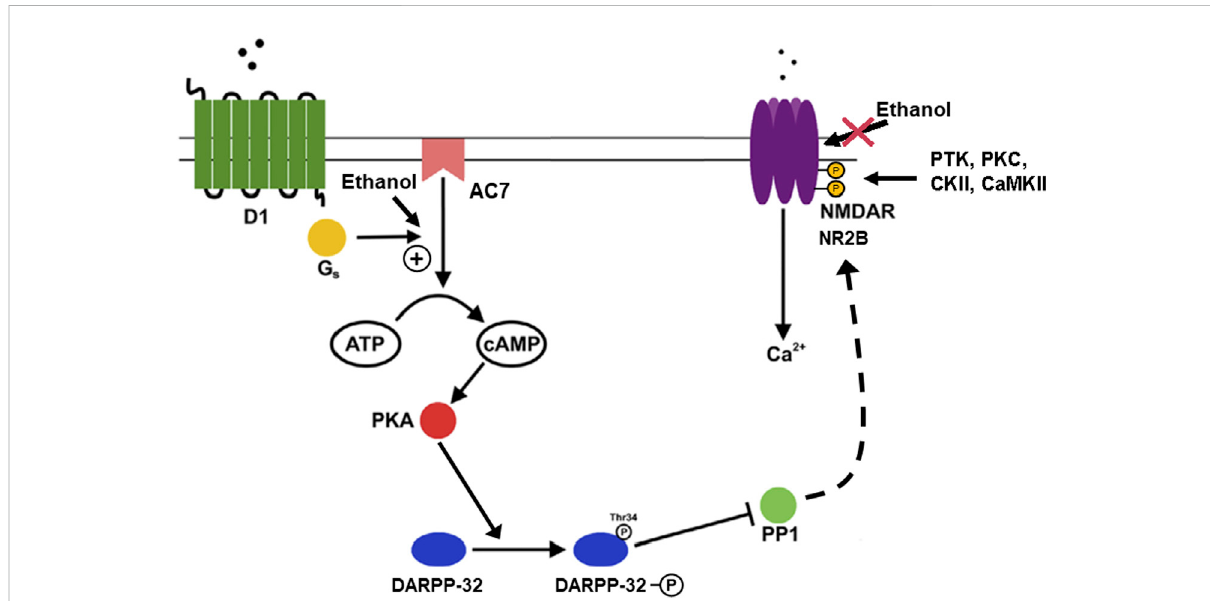
FIGURE 4 Phosphorylation of DARPP-32 mediated by dopamine through AC7 and actions of ethanol. The activity of medium spiny neurons (GABAergic neurons) in the nucleus accumbens and other areas of the striatum are important in the control of reward-related dopamine signals mediated via D1andD2dopaminereceptors,withD1receptorsactingtoenhancedendriticexcitability(Surmeieretal.,2007).Theincreaseindendriticexcitability isproposed tobedependentonmodulationofcortico-striatalglutamatergicsignaling via NMDA receptorslocatedonthedendriteswhichalso contain the D1 receptors. The link between the dopamine and glutamate signals is provided by the actions of PKA, DARPP-32, and protein phosphatase 1 (PP1) (Fernandez et al., 2006). The fi gure illustrates that ethanol, by acting on AC7, increases the production of cAMP which activates PKA,whichinturn phosphorylates DARPP-32 on threonine 34.When phosphorylated onthreonine 34, DARPP actsas aninhibitorofPP1,preventing dephosphorylationofthePP1substrates.OneofthePP1substratesistheNMDAreceptorwhichisasubstrateforphosphorylationbyproteintyrosine kinases(PTK),PKC,caseinkinase(CKII),andcalciumcalmodulinkinase(CaMKII)(ChenandRoche,2007).TheNMDAreceptor/channelismoreactive in its phosphorylated state (Nakazawa et al., 2001), and also resistant to the inhibitory effect of ethanol on the NMDA receptor/channel (Hoffman et al., 1989; Miyakawa et al., 1997). The overall result of these events is the sparing of the NMDA receptor from the inhibitory effects of ethanol in particular neuronal populations (Yaka et al., 2003). The implication is that ethanol can depress excitatory glutamatergic activity in certain types of cellsandbrainareas,butthereward-relatedneuronsofthestriatumwouldbesparedfromthisinhibitoryeffectofethanolbytheactionofDARPP-32 via